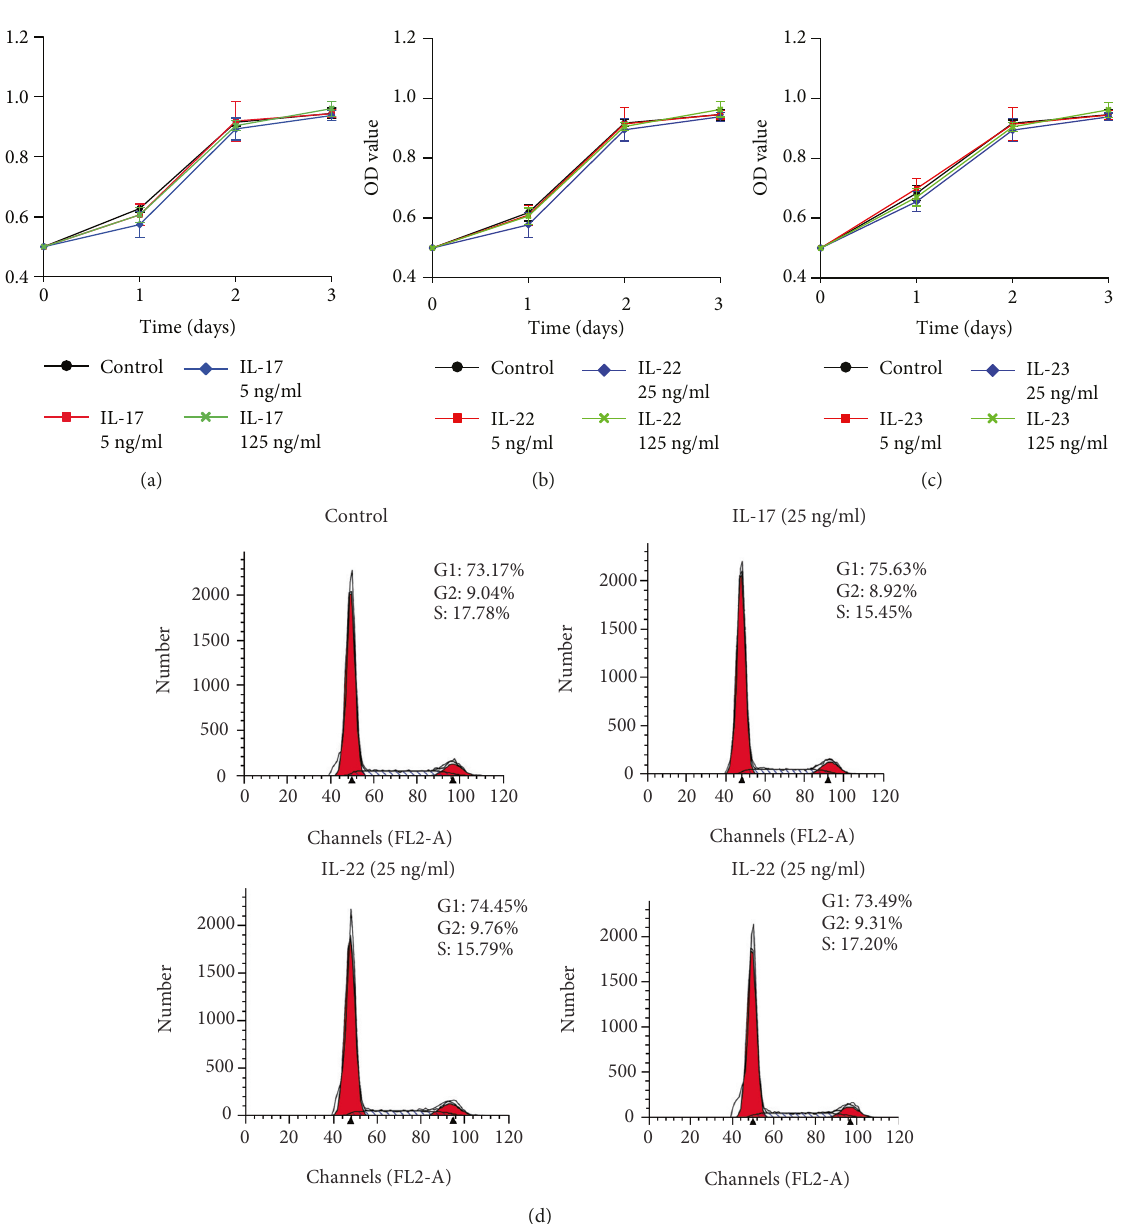
Figure 3: The e ff ects of IL-17, IL-22, and IL-23 on the proliferation and cell cycle of the rat primary osteoblasts. (a – c) Proliferation of primary osteoblasts was tested by a CCK-8 assay after the cells were treated with various concentrations of IL-17, IL-22, and IL-23 (0, 5, 25, and 125 ng/ ml) for di ff erent periods (24 h, 48 h, and 72 h). (d) Cell cycle analysis of primary osteoblasts were determined by fl ow cytometry after the cells were stimulated with or without IL-17 (25 ng/ml), IL-22 (25 ng/ml), and IL-23 (25 ng/ml) for